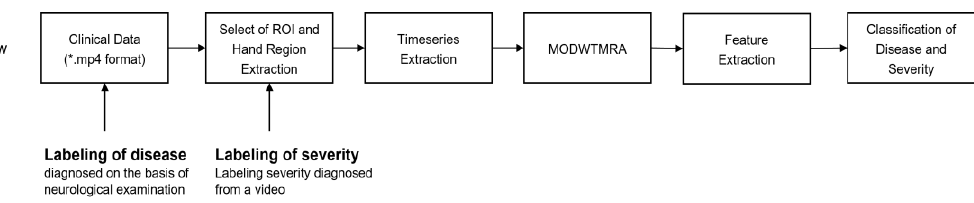
Figure 1. The overall proposed system for extracting clinical data (* refers to the file